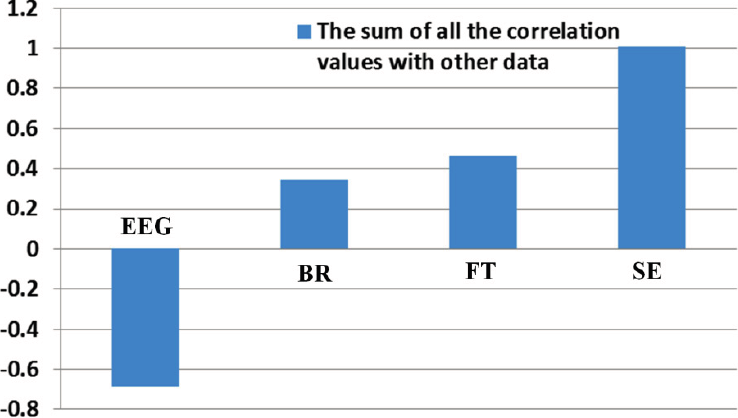
Figure 15. Calculated summed value of all the correlation